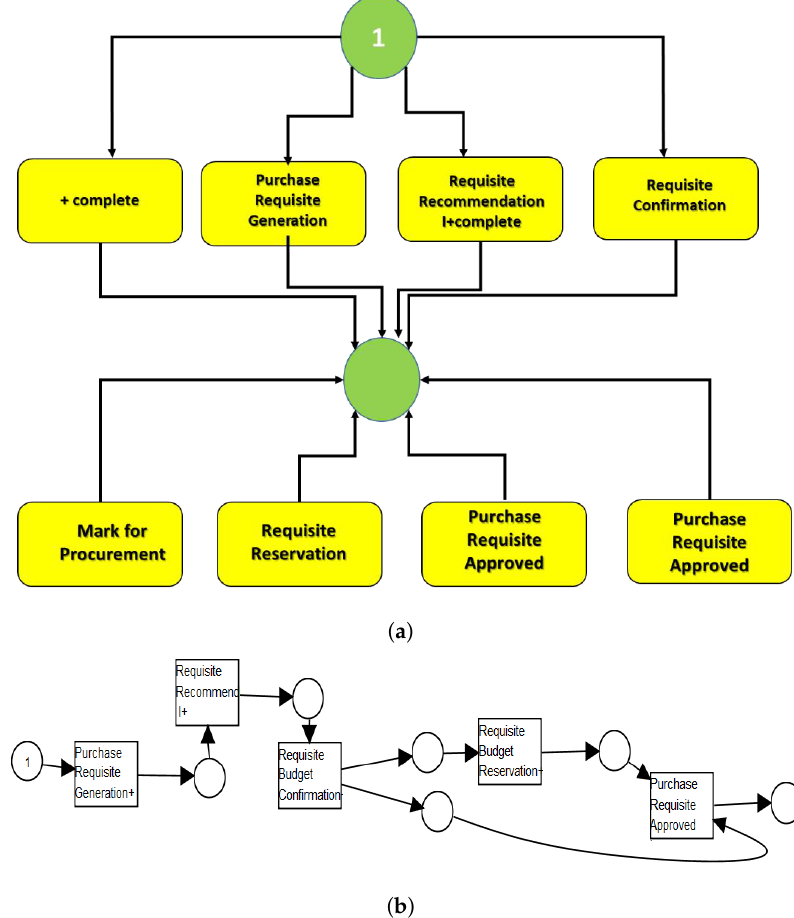
Figure 7. ( a ) Petri net generated by alpha miner on the original log data and ( b ) Petri net generated by alpha miner after